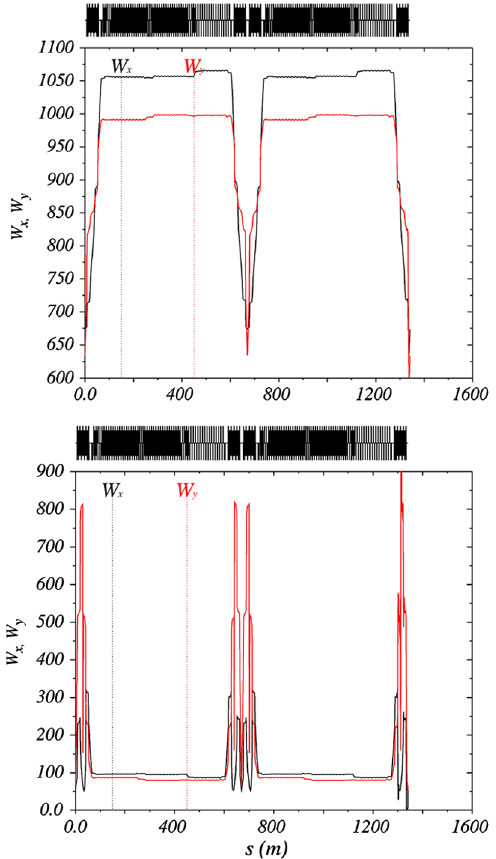
FIG. 9. Horizontal and vertical chromatic amplitude functions W x;y plotted over the whole ion collider ring length before (top) and after (bottom) the linear chromaticity compensation.